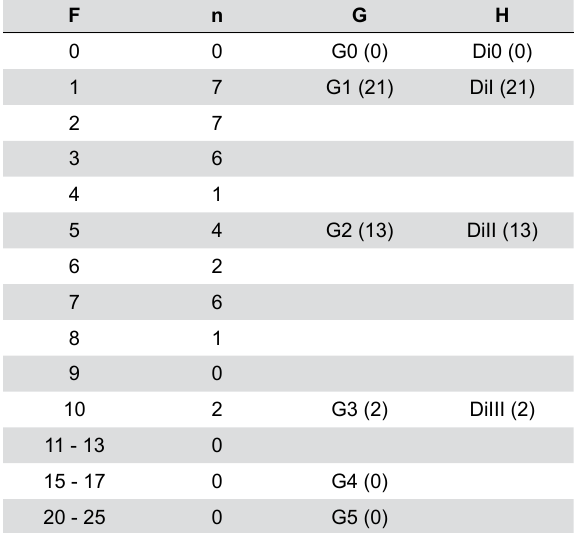
Table 3- Number of patients classified after the Helkimo clinical dysfunction score, group and index